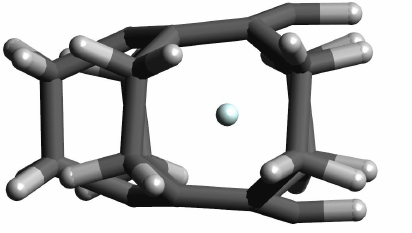
Figure 7. The structure of the He@[2 5 ](1,2,3,4,5)cyclophane